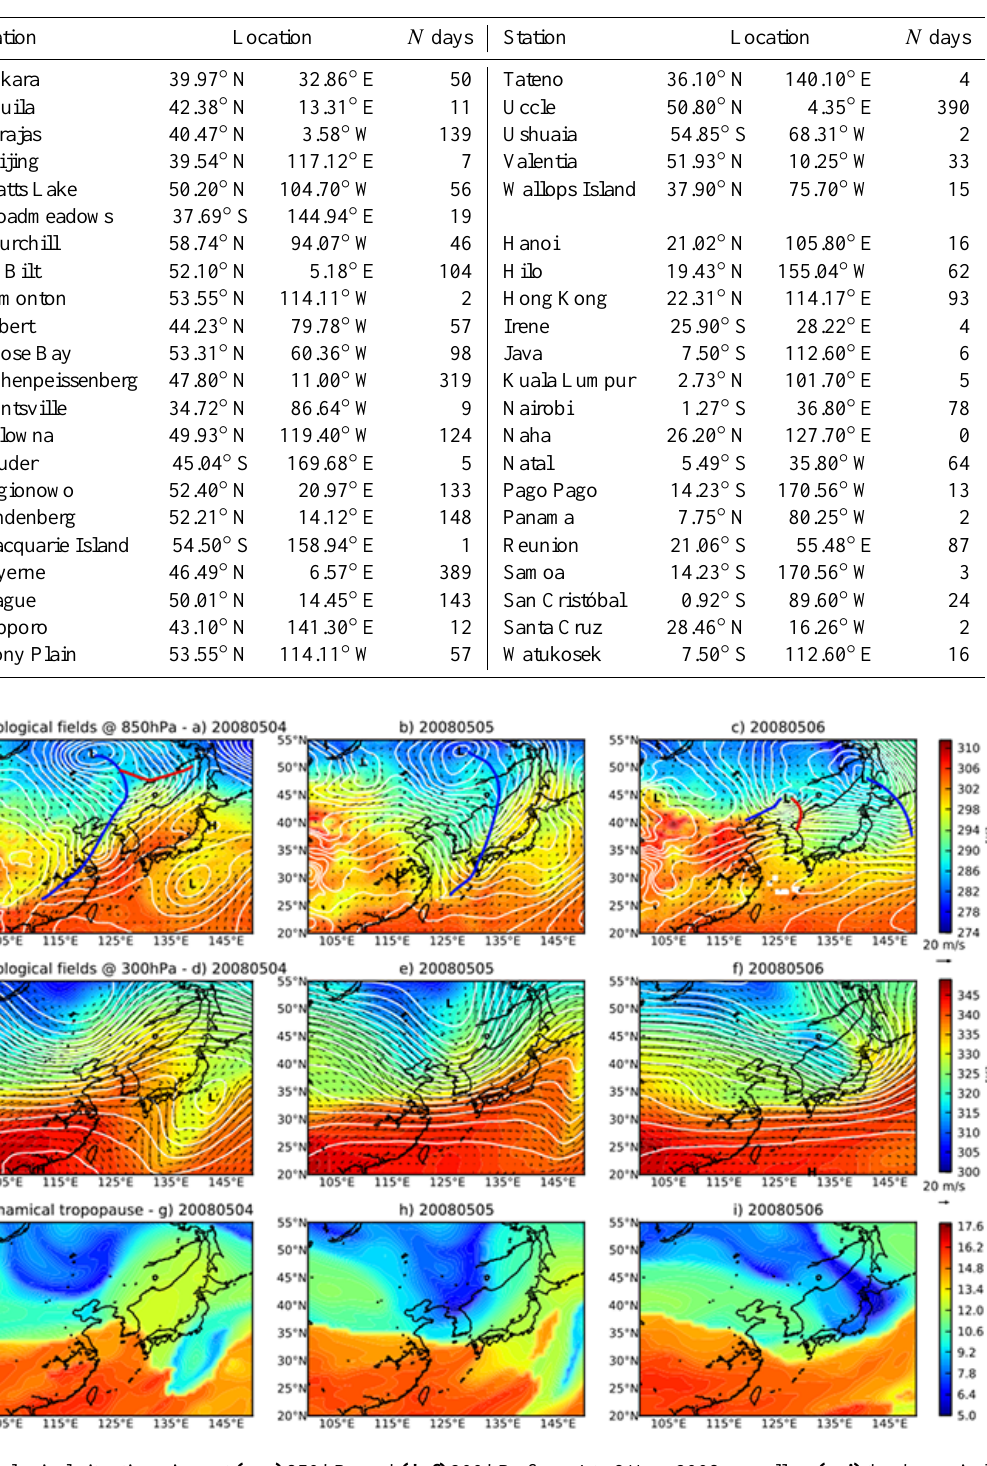
Figure 1. Meteorological situation given at (a–c) 850hPa and (d–f) 300hPa from 4 to 6 May 2008 as well as (g–i) the dynamical tropopause. All the meteorological variables are derived from the ERA-Interim reanalysis. The coloured areas in (a–f) represent the equivalent potential temperature and the white contours the geopotential height. The “L” and “H” symbols represent the centre of lows and highs respectively. Horizontal winds are also plotted. The cold and warm fronts are displayed in blue and red respectively on the top